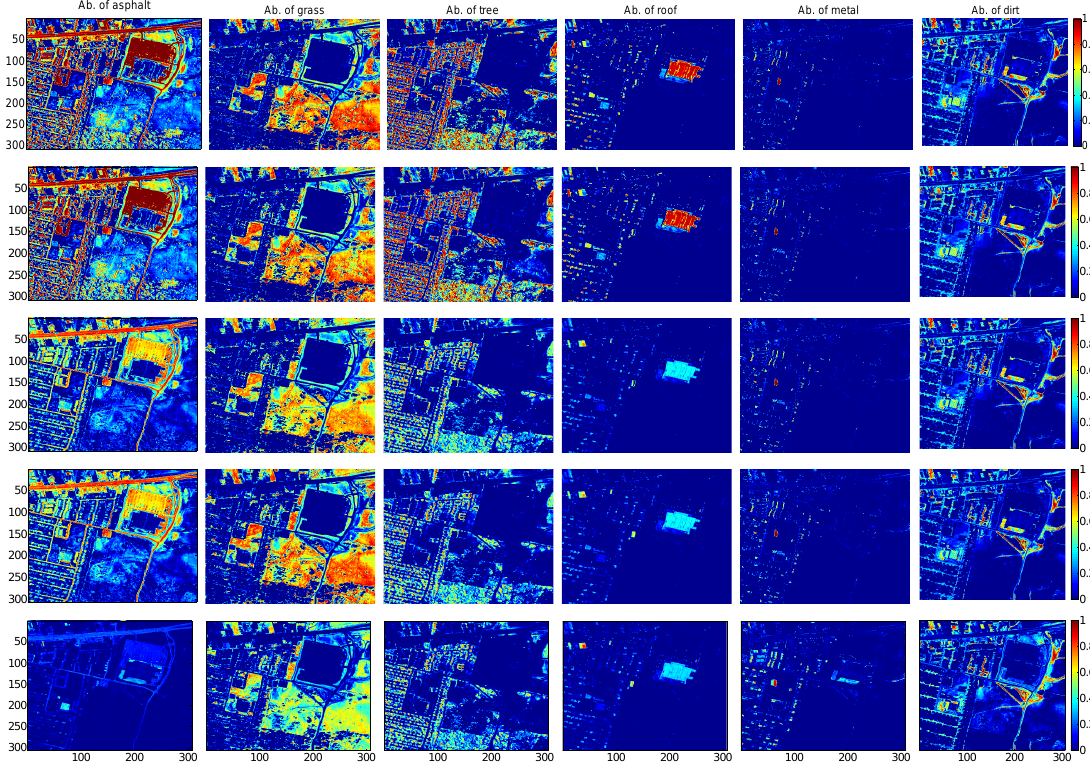
Figure 11. Abundance maps estimated by the proposed NU-BGBM and the compared methods for the Urban real HSI. From top to bottom: estimated visual ground truth, FCLS, GDA, semi-NMF, BPOGM, and NU-BGBM.